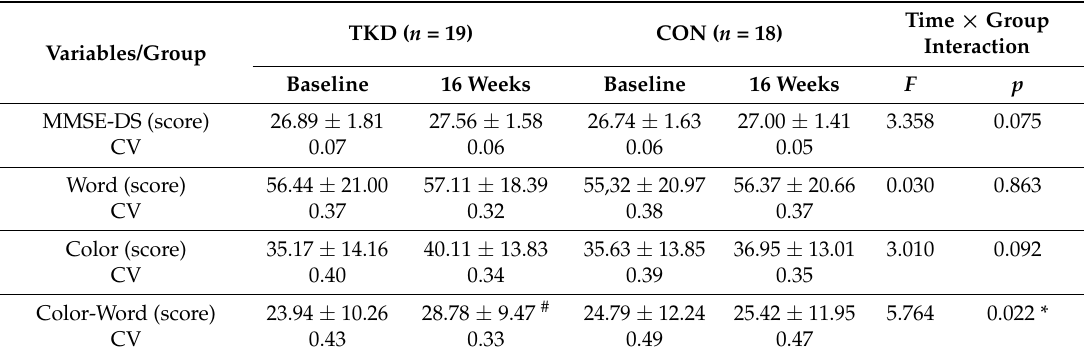
Cognitive function parameters in the TKD and CON groups before and after the 16-week